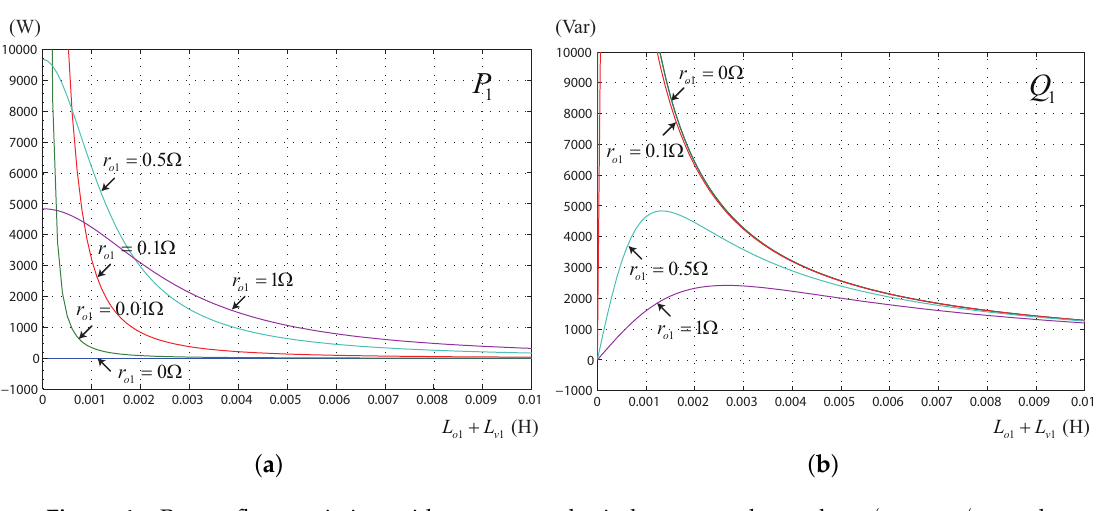
Figure 4. Power flow variation with respect to the inductance values when (cid:54) v o 1 = (cid:54) v L and | v | = 1.05 | v | : ( a ) real power flow; ( b ) reactive power flow. L o 1